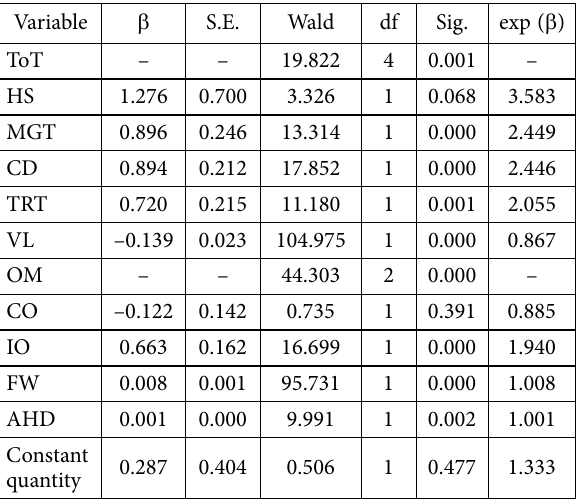
Table 3. Analysis results of traditional BLR model